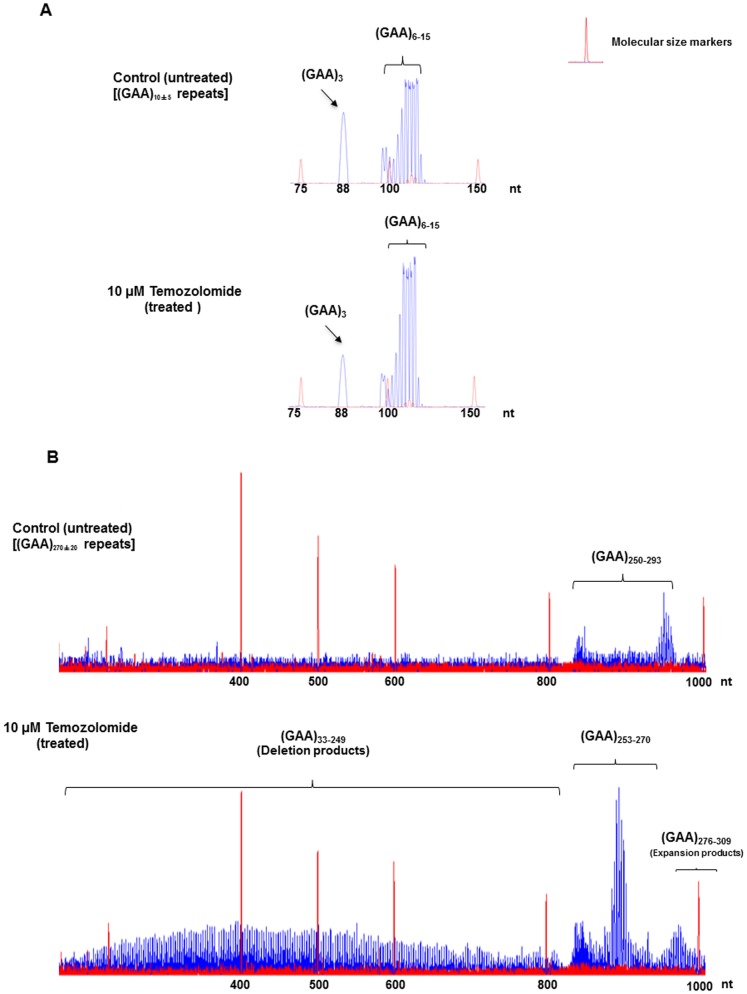
GAA repeat instability induced by temozolomide in the normal and FRDA lymphoblasts.(A) Lymphoblasts derived from a normal individual were treated with 10 μM temozolomide according to the procedure described in the Materials and Methods. Panel A represents the result from untreated cells. Panel B represents the result from the cells treated with 10 μM temozolomide. (B) FRDA patient lymphoblasts that contained 280 GAA repeats were treated with 10 μM temozolomide according to the procedure described in the Materials and Methods. Panel A illustrates the result from untreated cells. Panel B represents the result from temozolomide treated cells. DNA fragments including repaired products are illustrated as individual peaks. The height of a peak represents the abundance of a repair product with a specific size. The sizes of repair products are illustrated in nucleotides. Size standards are indicated.